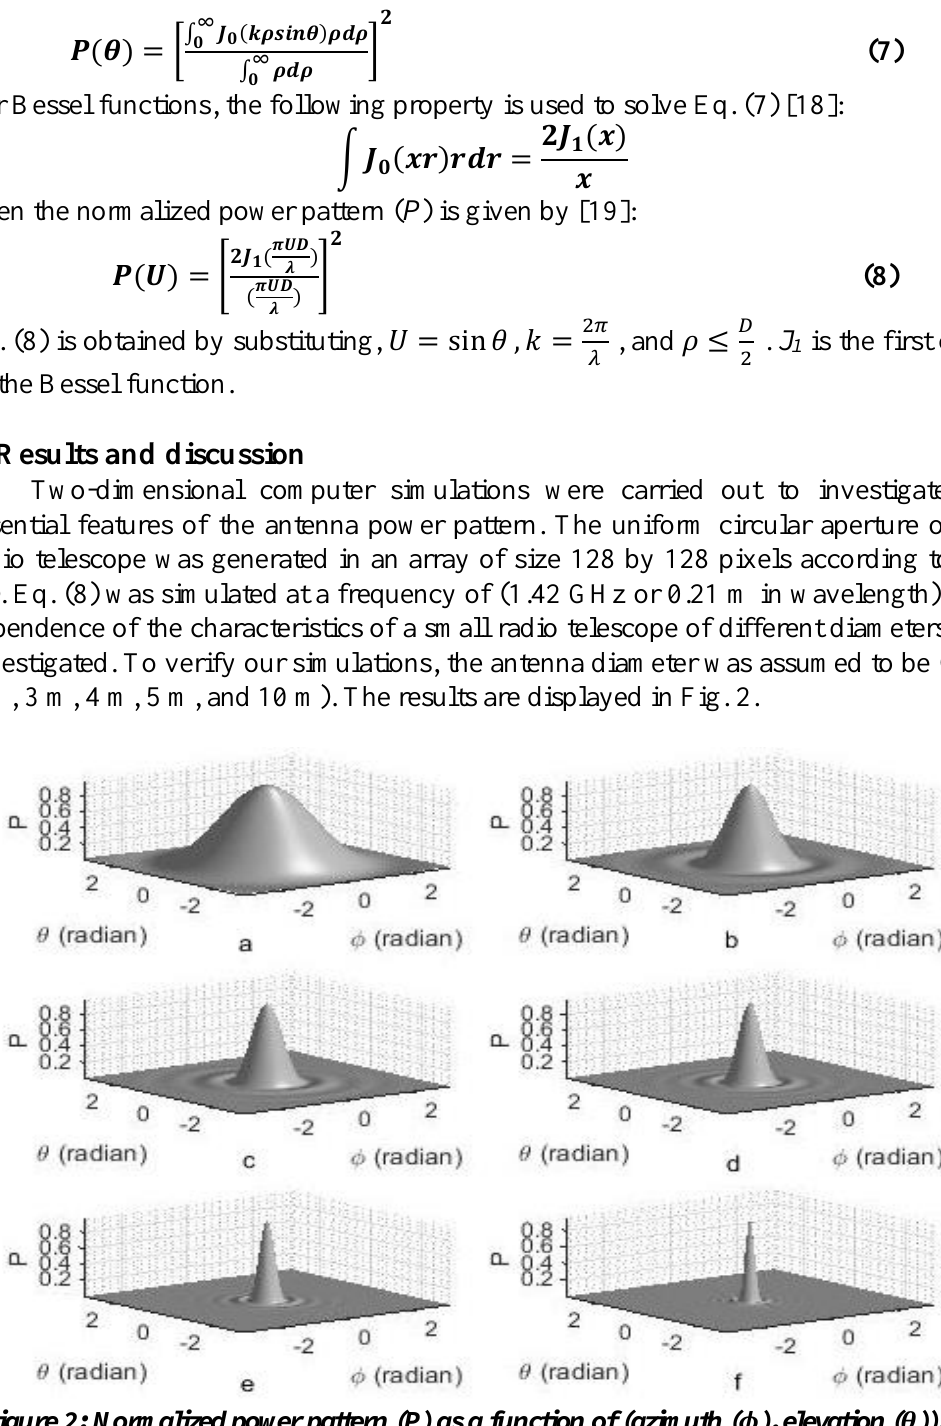
Figure 2: Normalized power pattern (P) as a function of (azimuth ( 𝝓 ), elevation ( 𝜽 )): a – Antenna diameter (D = 1 m), b – Antenna diameter (D = 2 m), c – Antenna diameter (D = 3 m), d – Antenna diameter (D = 4 m), e – Antenna diameter (D = 5 m), and f – Antenna diameter (D = 10